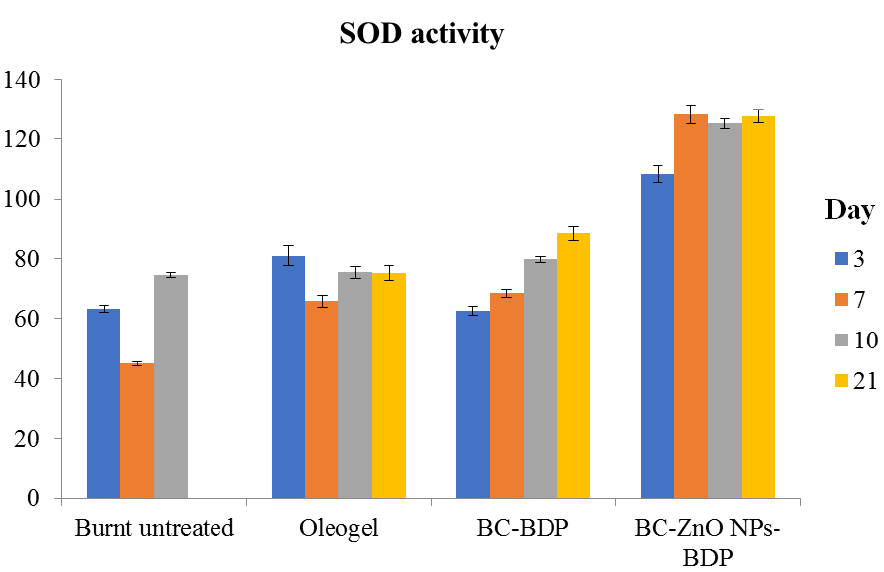
Figure 13. Diagram of changes in superoxide dismutase (SOD) activity during treatment with the studied agents (% of control), 100%—1037.762 ± 21.351% ng min −1 mg protein −1 . The number of experiment replications was equal to 3. p < 0.001.